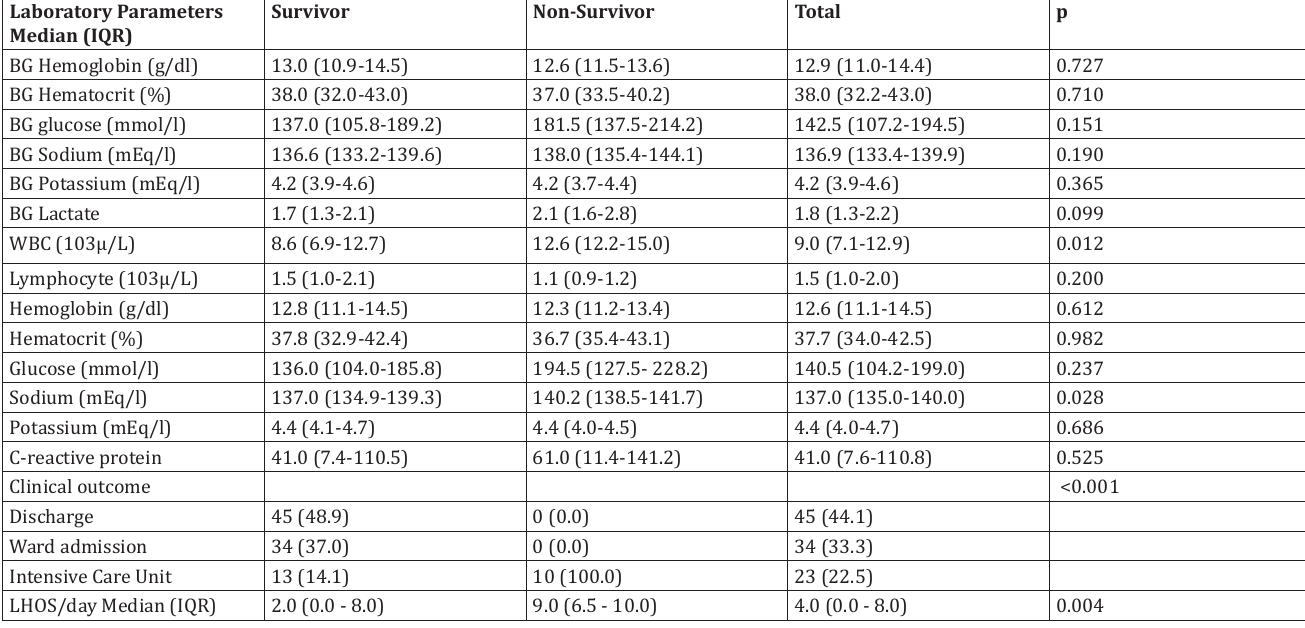
(COPD, chronic obstructive pulmonary disease; CAD, coronary artery disease; CHF, Chronic heart failure; CVD, cerebrovascular disease; CRF, Chronic renal failure; DVT, deep vein thrombosis) Laboratory parameters, clinical outcome and 30-day mortality of patients Laboratory Parameters Median